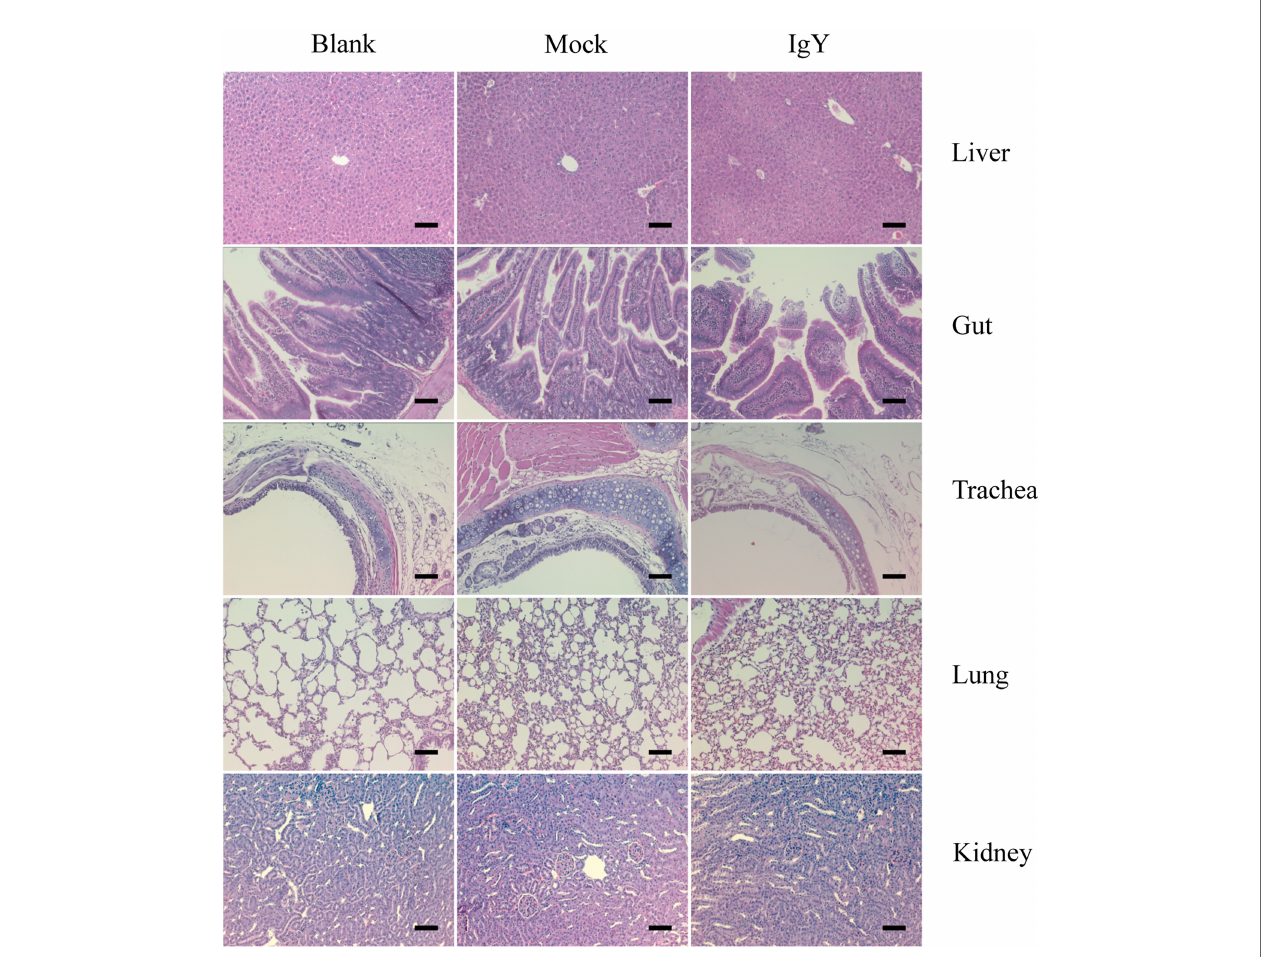
FIGURE 3 | Safety of IgY-R through histopathological assessment of liver, gut, trachea, lung, and kidney of mice. No visible lesions were found on any of the slides analyzed (six slides per tissue sample). Representative images are shown. Image amplitude: 20x Scalebars: 200